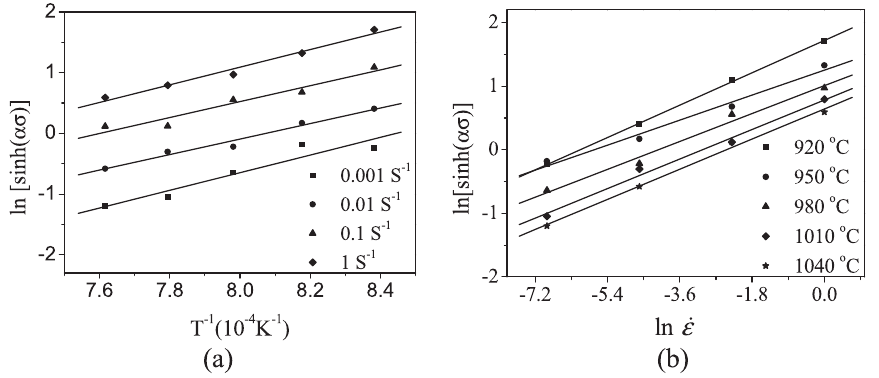
Figure 3: Relationships between: (a) ln sin h ασ ð Þ½ (cid:2) ~ln _ ε ; (b) ln sin h ασ ð Þ½ (cid:2) ~ T − 1